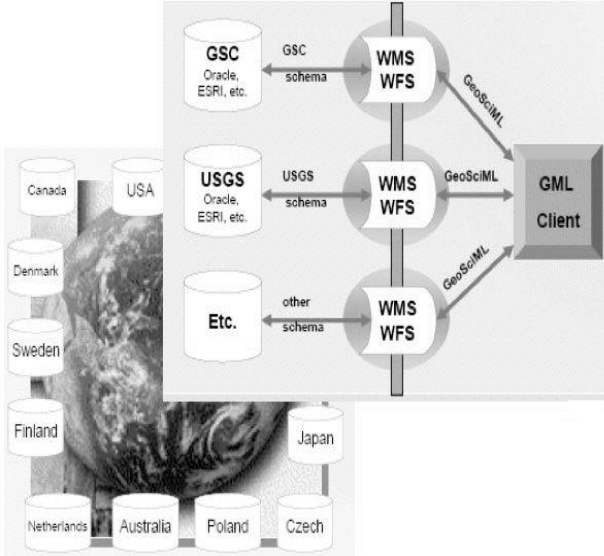
Figure 5. Sample integrated sensored webGIS GeoSciML is being worked on by EU, US, Canadian, Japanese